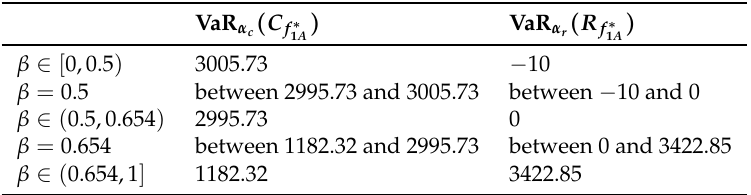
Table 1. VaRs of the cedent and the reinsurer when f ∈ C 1